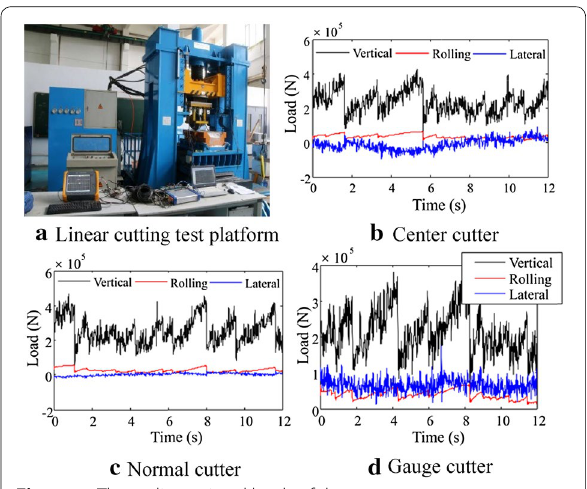
Figure 5 Three-dimensional loads of the cutters